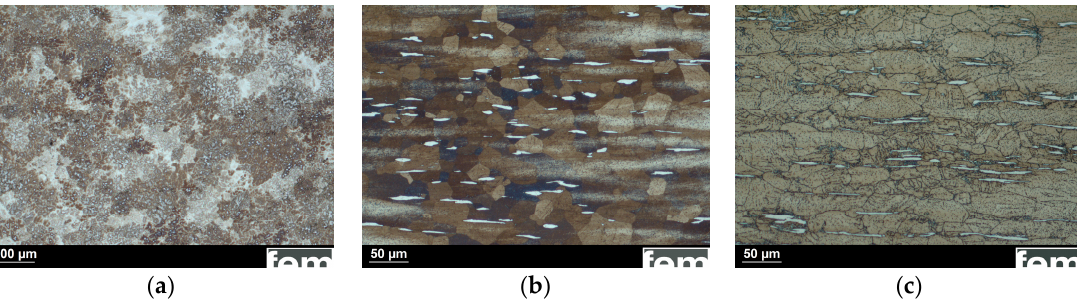
Figure 2. Optical micrograph of: ( a ) the as-cast Zn-4Ag dendritic microstructure; ( b ) longitudinal sections after thermomechanical treatment (homogenization, swaging and solution annealing); and ( c ) after precipitation hardening showing globular grains. Large ε -AgZn 3 grains (bright) can be identified in the cross-sections. Table 1. Assessment of mechanical properties by tensile testing and Vickers hardness tests.